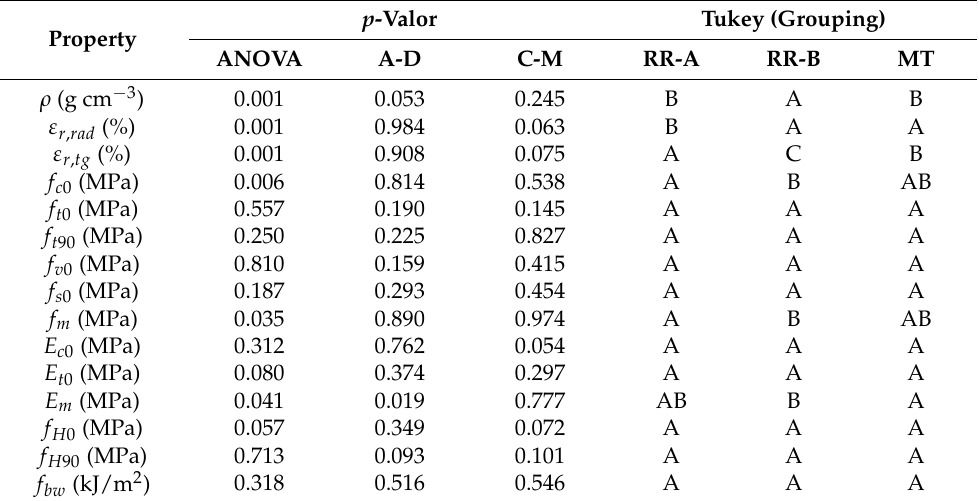
Table 5. Results of ANOVA and Tukey’s test for physical and mechanical properties of Tabebuia sp. p -Valor Tukey (Grouping) Property ANOVA